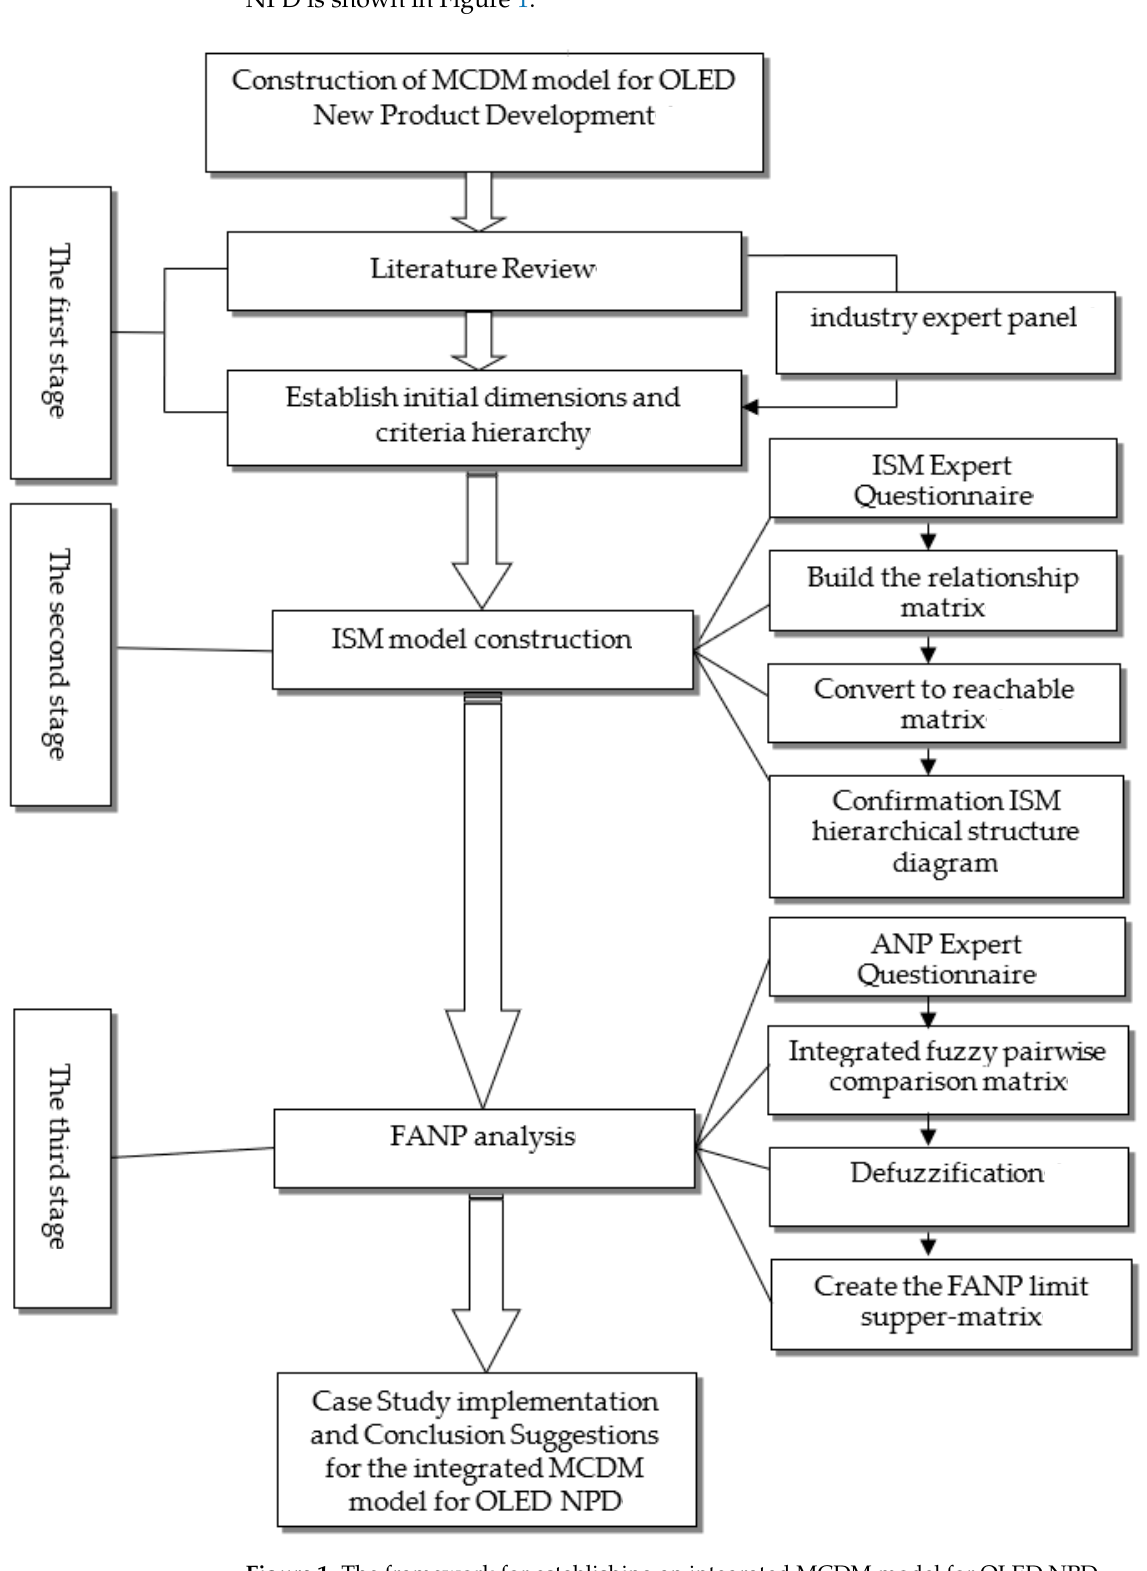
Figure 1. The framework for establishing an integrated MCDM model for OLED NPD.